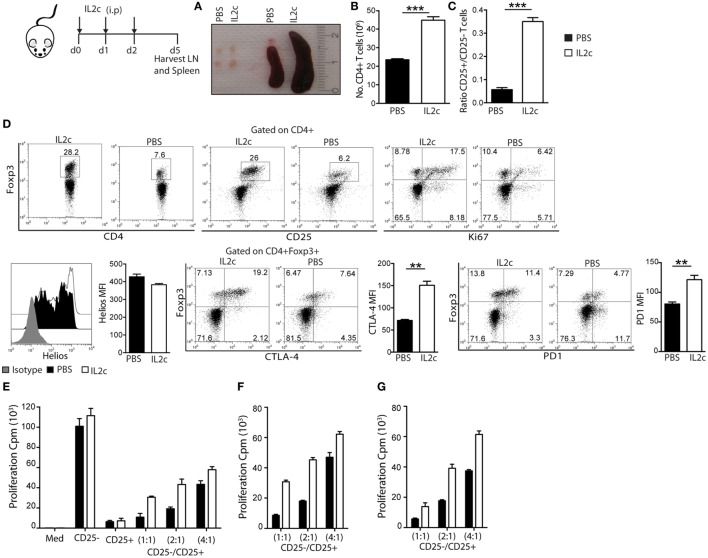
Phenotype and suppressive function of regulatory T cells expanded in vivo with IL2c. BALB/c mice received IL2c (open bars) or PBS (solid bars) treatment i.p. on days 0, 1, and 2. On day 5, spleen and peripheral axillary and inguinal lymph nodes (LN) were harvested. (A) Peripheral LN and spleen in PBS and IL2c-treated mice. (B) Total number of CD4+ T cells in pooled spleen and LN after T-cell purification. (C) Ratio of CD25+/CD25− within purified CD4+ T cells. (D) Representative plots and summary data of LN cells for the expression of Foxp3, CD25, Ki67, Helios, CTLA-4, and PD-1 (gated on CD4+ or CD4+Foxp3+). (E) CD4+CD25− T cells (1 × 105) were cultured alone or cocultured with CD4+CD25+ T cells (cell ratios of 1:1, 2:1, or 4:1) and anti-CD3/CD28 beads. Alternatively, (F) CD25− subset isolated from PBS-treated cultured with CD25+ from PBS or IL2c-treated mice; or (G) CD25− from IL2c-treated with CD25+ from PBS or IL2c-treated mice; in the presence of anti-CD3/CD28 beads. All conditions were plated in triplicates and the data are representative of three independent experiments. Dot-plots show the percentage of subsets within regions/quadrants, bar graphs represent mean ± SEM. n = 3–4 mice/group (*P < 0.05, **P < 0.01, and ***P < 0.001).